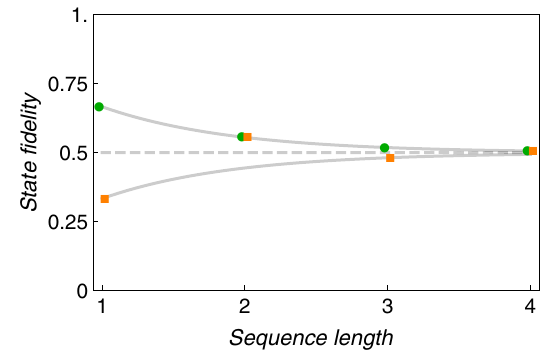
FIG. 1. RB decays used to estimate the fidelity between an ideal ˆ C ˆ C p ¼ 1 Hadamard gate and ) and 0 (green circles, with 1 (orange 3 squares, with p ¼ − 1 ). The decays corresponding to each of the 3 remaining average fidelities coincide with one of these two representative decays. Note that these decays are much faster than decays previously estimated in RB, as they correspond to the average fidelities between very different maps. The data points are offset along the x axis for